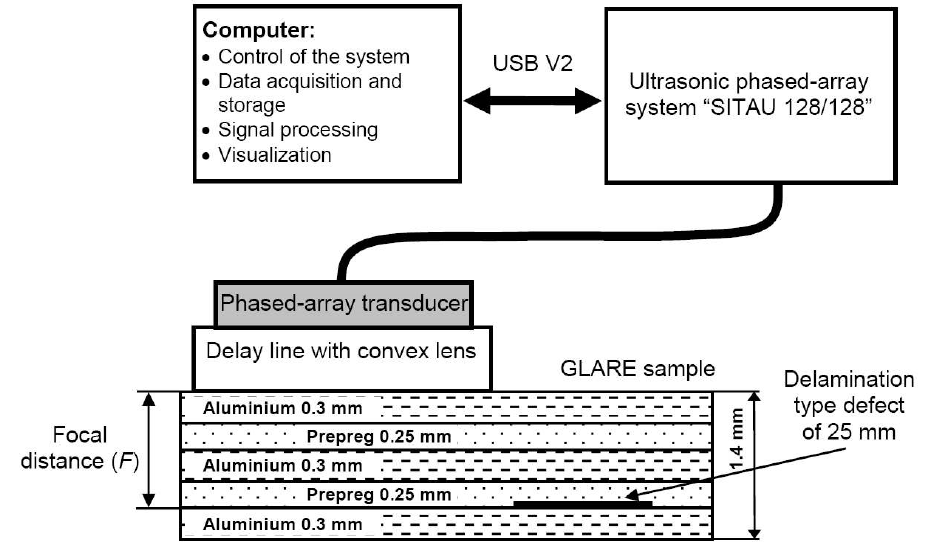
Figure 8. Experimental setup of the defects detection in the GLARE sample using the ULPAT and particular Plexiglas delay line in the following cases: focusing in the azimuth cross-section and with dual focused beam in the elevation and azimuth cross-sections using the convex cylindrical lens (the radius of the curvature is R = 17 mm).